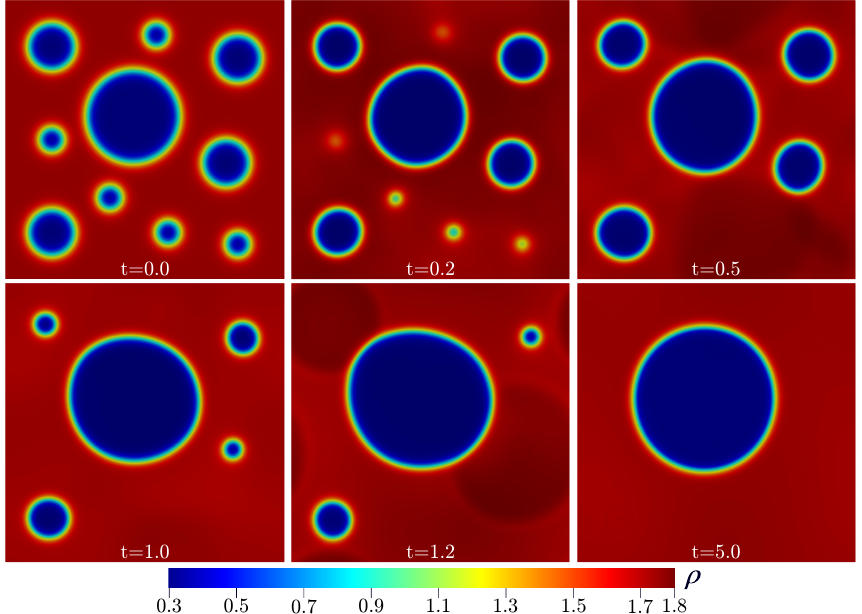
Figure 10. Numerical result for the density ρ , obtained by our curl-free scheme for the two- dimensional Ostwald ripening test case. Results are plotted at times t We recall that the values used here are ρ l = 1.8, ρ v = 0.3, γ = 2 c s = 10 and an effective viscosity of µ = 10 − 2 . The total domain is Ω = [ discretized over a 4096 4096 uniform grid with periodic boundary ×